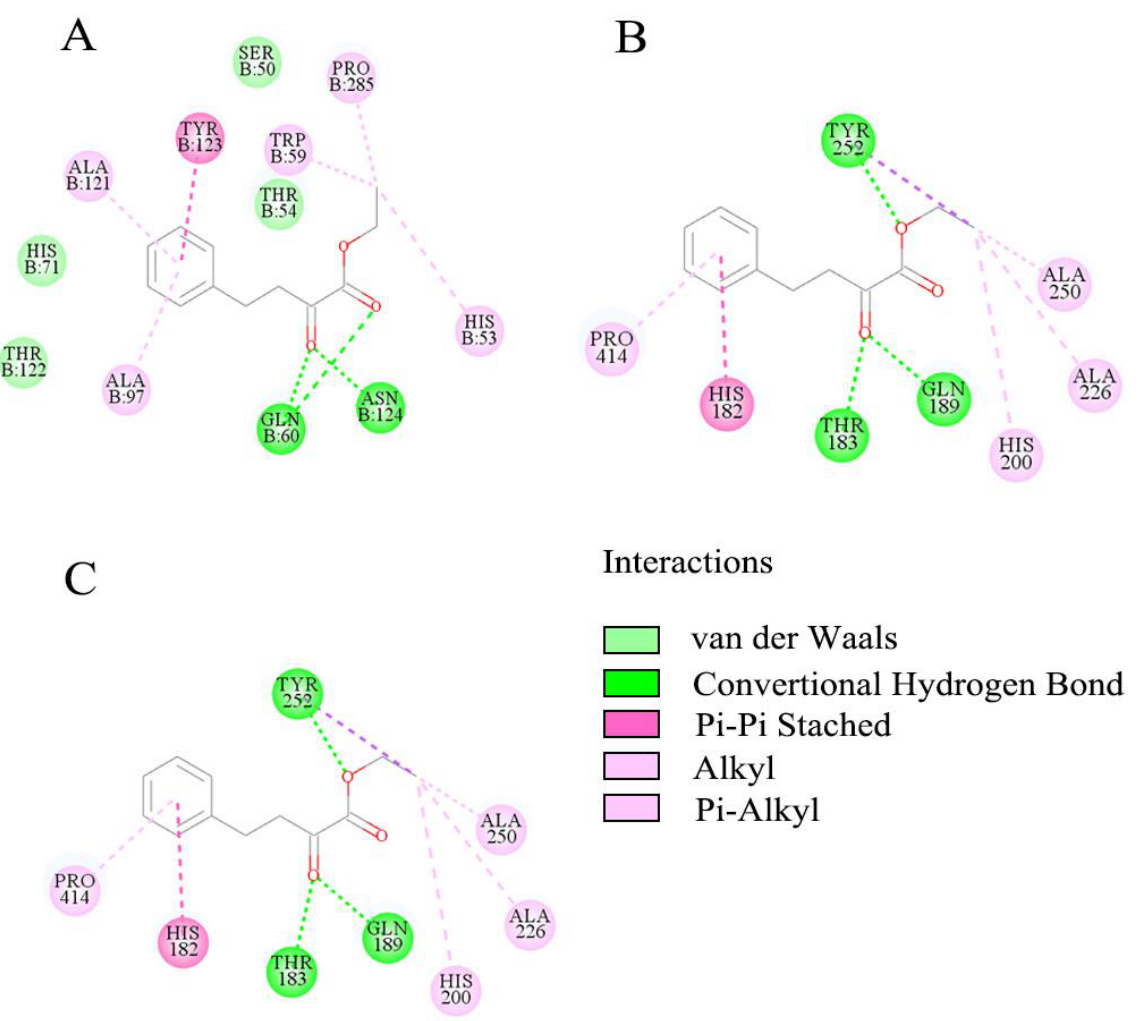
Figure 10. 2D view of the docking results. ( A ) Docking of substrate OPBE into the active site of CpCR. ( B ) Docking of substrate OPBE into the active site of SpyCatcher-CpCR. ( C ) Docking of substrate OPBE into the active site of SpyTag-CpCR.